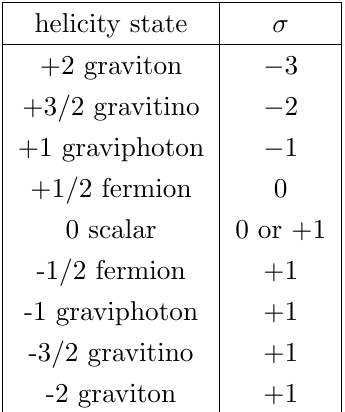
Table 2 . Holomorphic soft weights (cid:27) for the N = 8 supermultiplet. Note that the soft weights in this table follow from taking the soft limit holomorphically, j i i ! (cid:15) j i i for all states, independently of the sign of their helicity. At each step in the spectrum, the soft weight either changes by 1 or not at all. Note that one could also have used the anti-holomorphic de(cid:12)nition j i ] ! (cid:15) j i ] of taking the soft limit; in that case the soft weights would just have reversed, to start with (cid:27) = (cid:0) 3 for the negative helicity graviton, but no new constraints would have been obtained on the scalar soft weights. In N = 8 supergravity, the 70 scalars are Goldstone bosons of the coset E hence (cid:27) = 1. Including higher-derivative corrections may change this behavior to (cid:27) = 0 depending on whether the added terms are compatible with the coset